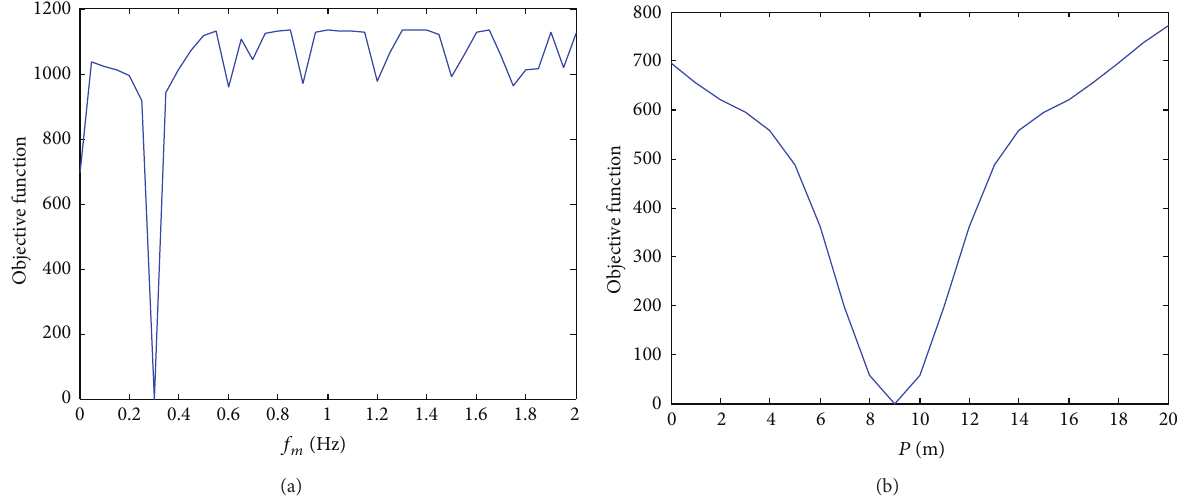
Figure 13: Objective function slices along (a) the rotating frequency and (b) the focus